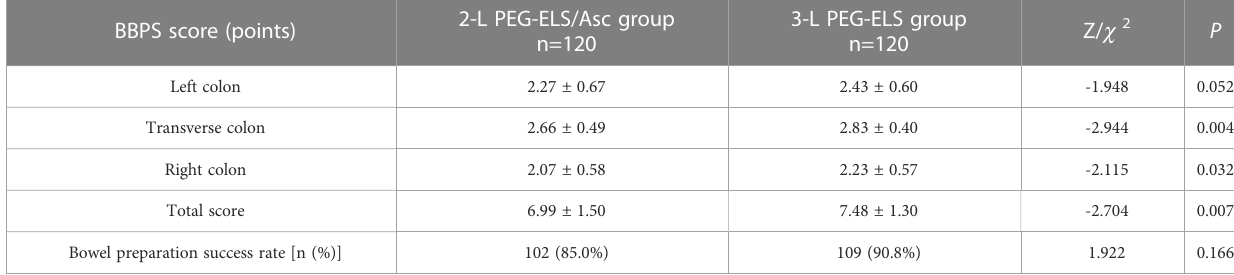
TABLE 2 Comparison of bowel cleansing effects between the two groups [M(25%, 75%)].